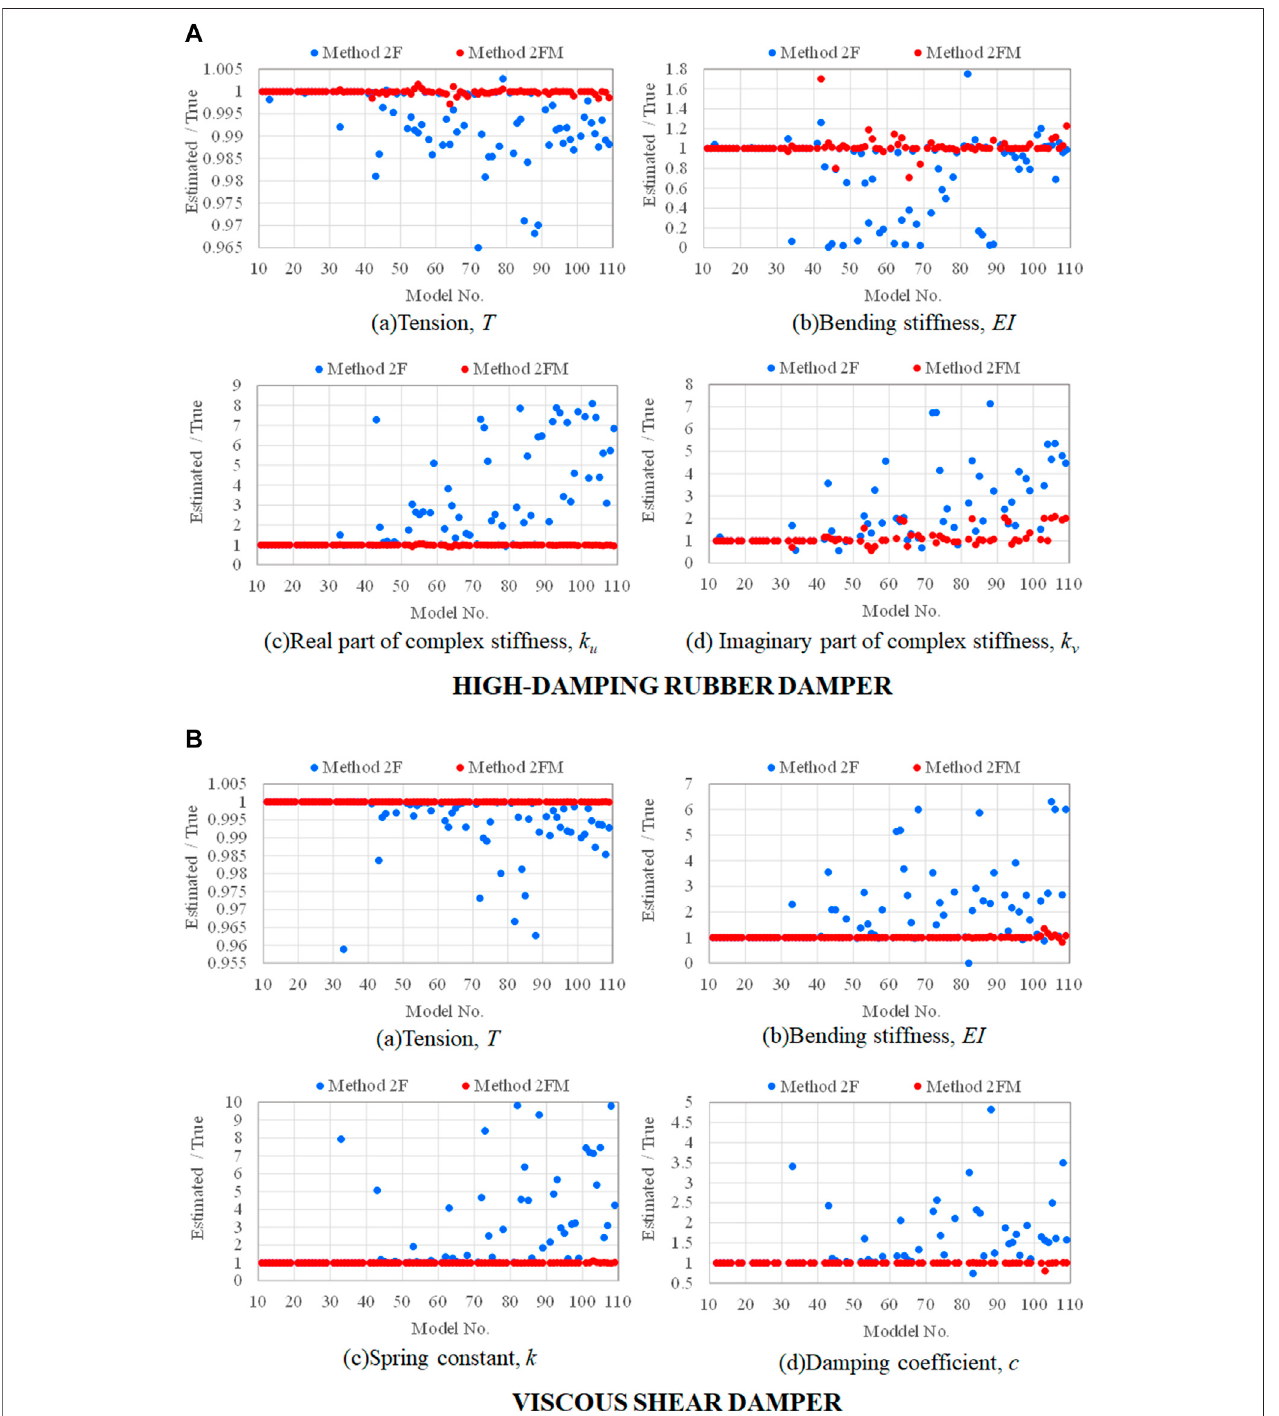
FIGURE 4 | Estimation results without measurement noise: (A) high-damping rubber damper; (B) viscous shear damper.